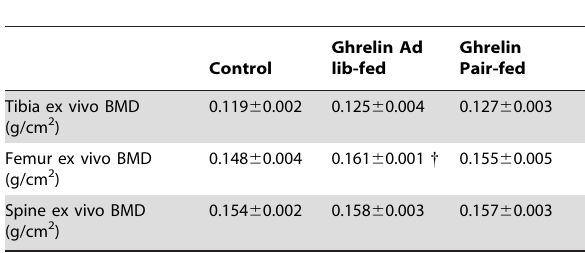
Table 1. Effect of chronic ICV ghrelin infusion on ex vivo BMD measurement of tibia, femur and spine by DXA.